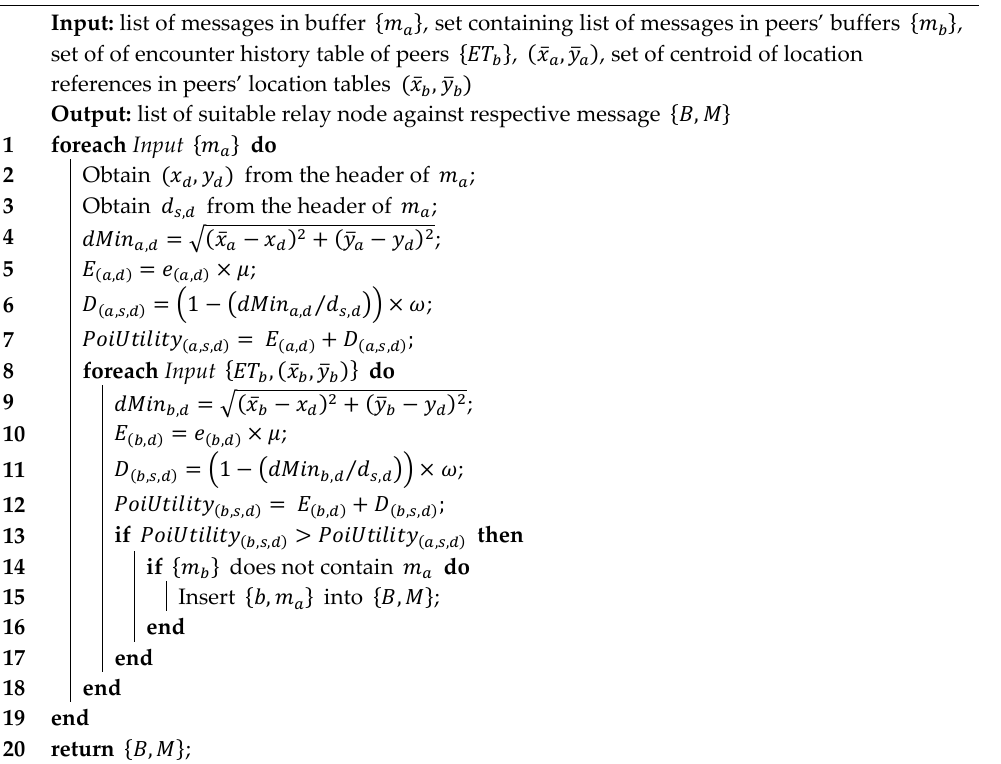
Algorithm 4. Selecting suitable relay nodes for messages with PoiFord